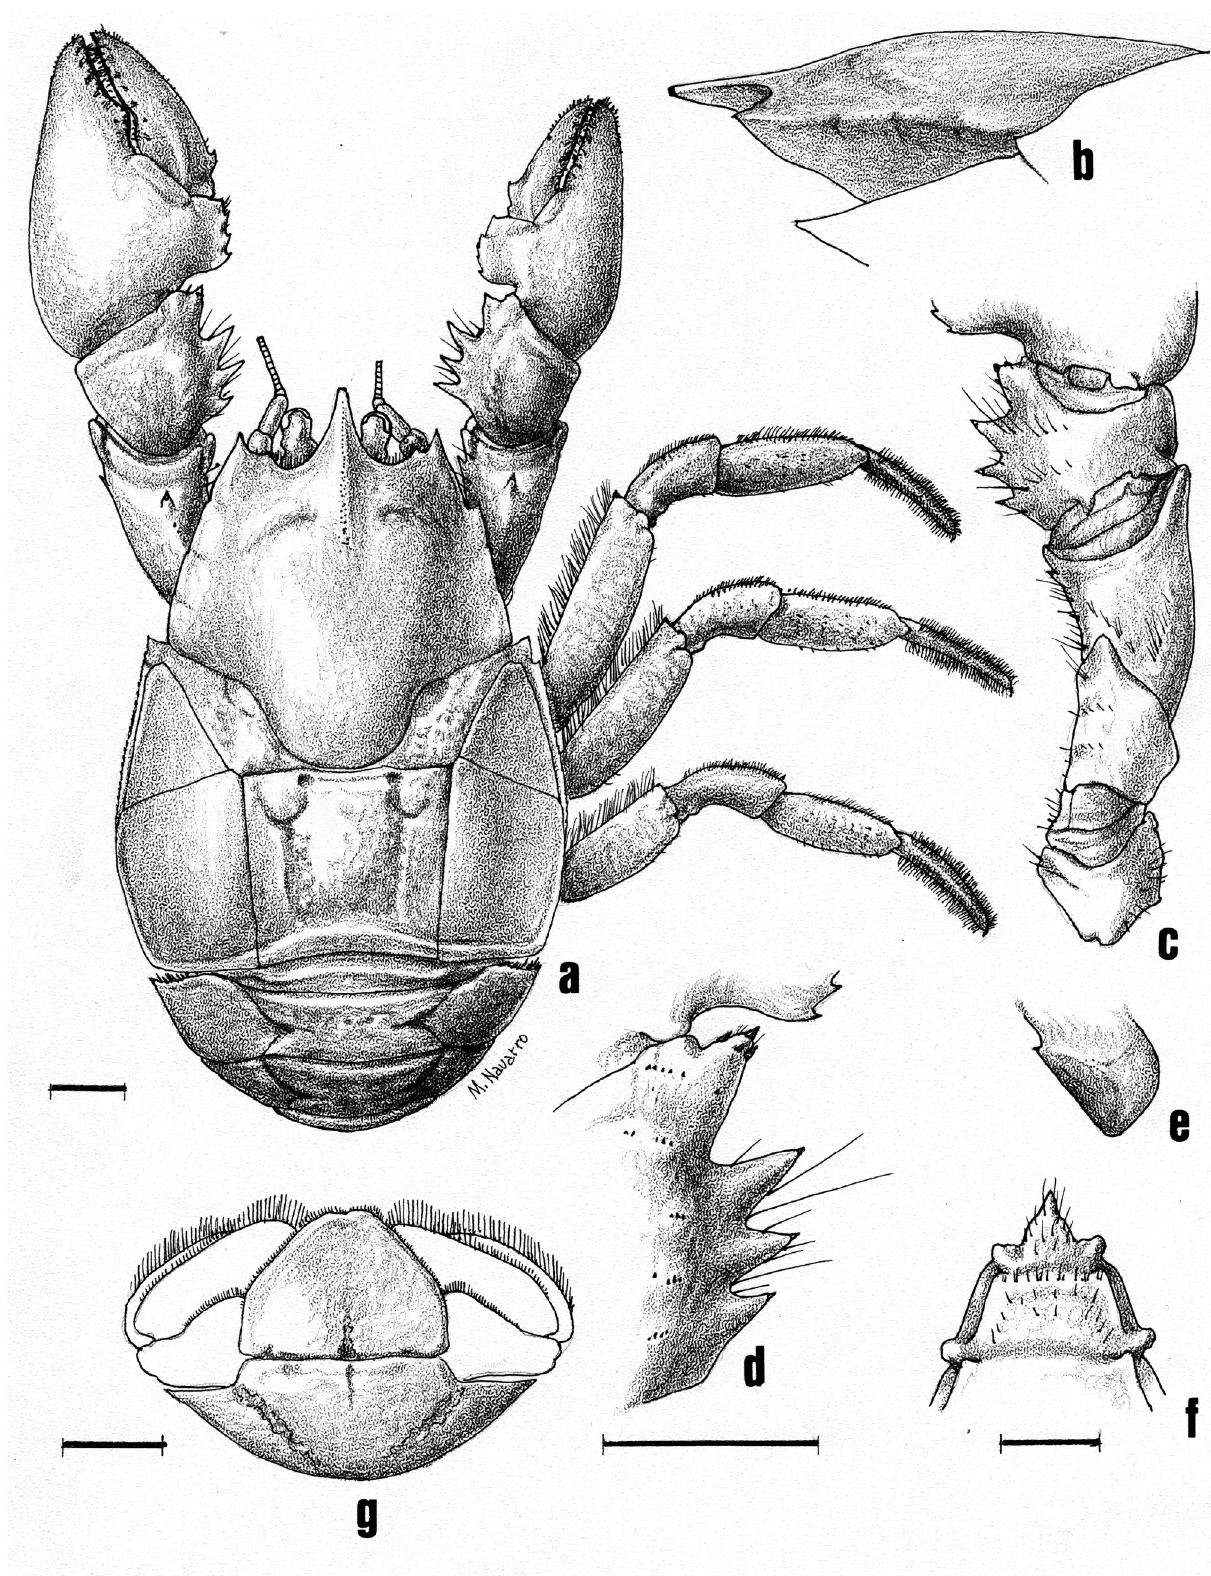
Figure 2. Aegla chilota n. sp., male holotype, MNHNCL DEC-15104. a, Dorsal view of carapace; b, lateral view of pre-cervical carapace; c, ventral view of proximal segments of left cheliped showing absence of tubercle on ventral face of carpus; d, enlarged dorsal view of carpus inner margin of left cheliped showing apical ornamentation of carpal lobe; e, lateral view of second abdominal epimeron; f, sternum of third and fourth thoracic segments; g, telson plate. Scale bar = 5